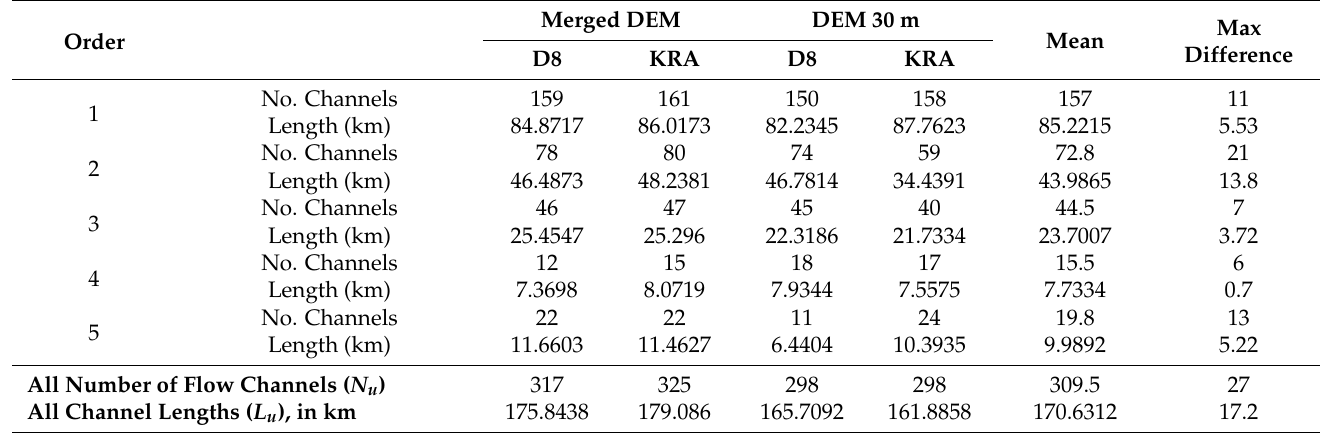
Table 8. Quantification of number and lengths